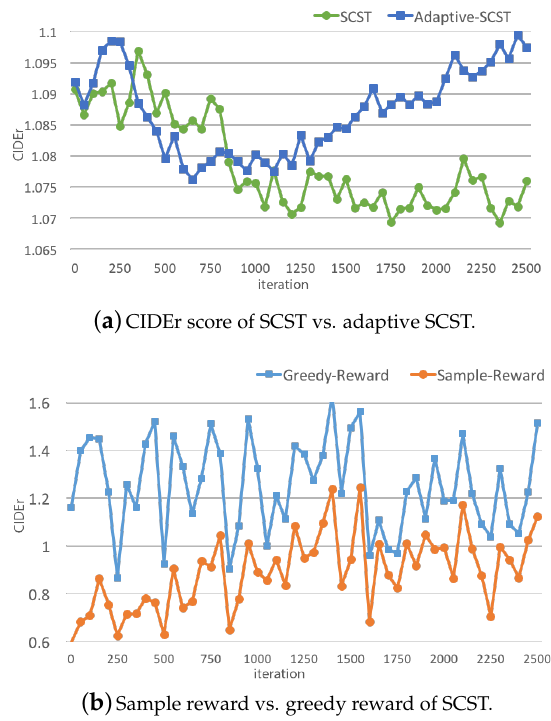
Figure 4. The above two figures show the unstable training problem of SCST. The x -axis is the number of iterations, and the y -axis is the CIDEr score. Image ( a ) shows the plot of CIDEr score over iterations of SCST and our adaptive SCST, and image ( b ) shows the rewards (sample reward and greedy reward) of each iteration of SCST. All models were trained with the MSCOCO dataset